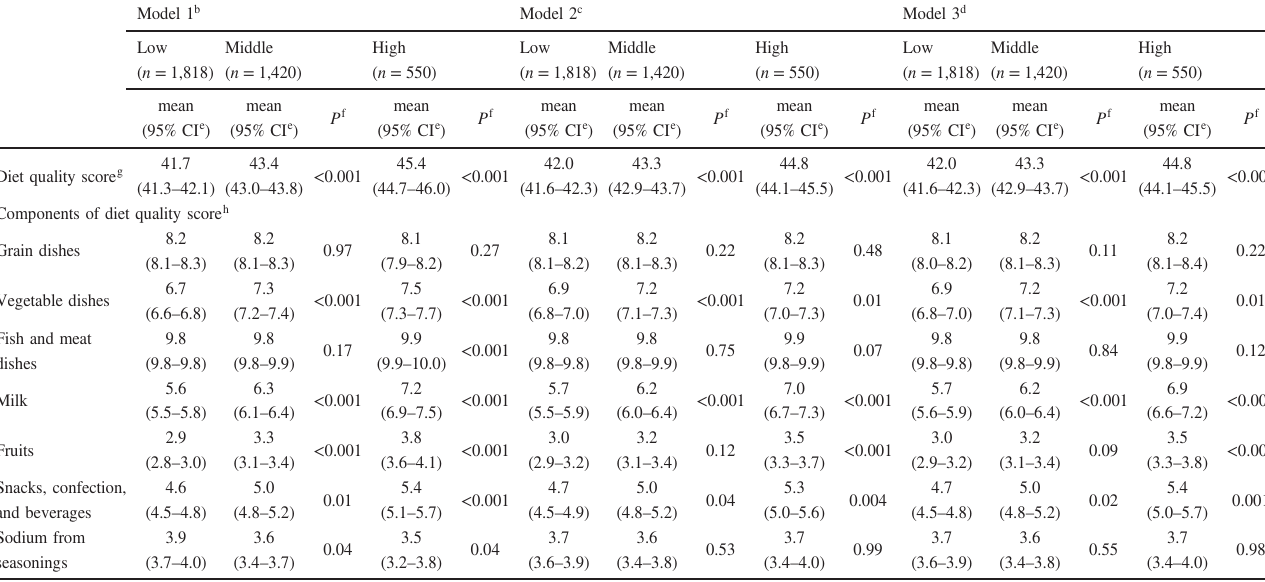
Table 2. Associations of education with components of diet quality score in middle-aged women ( n = 3,788)